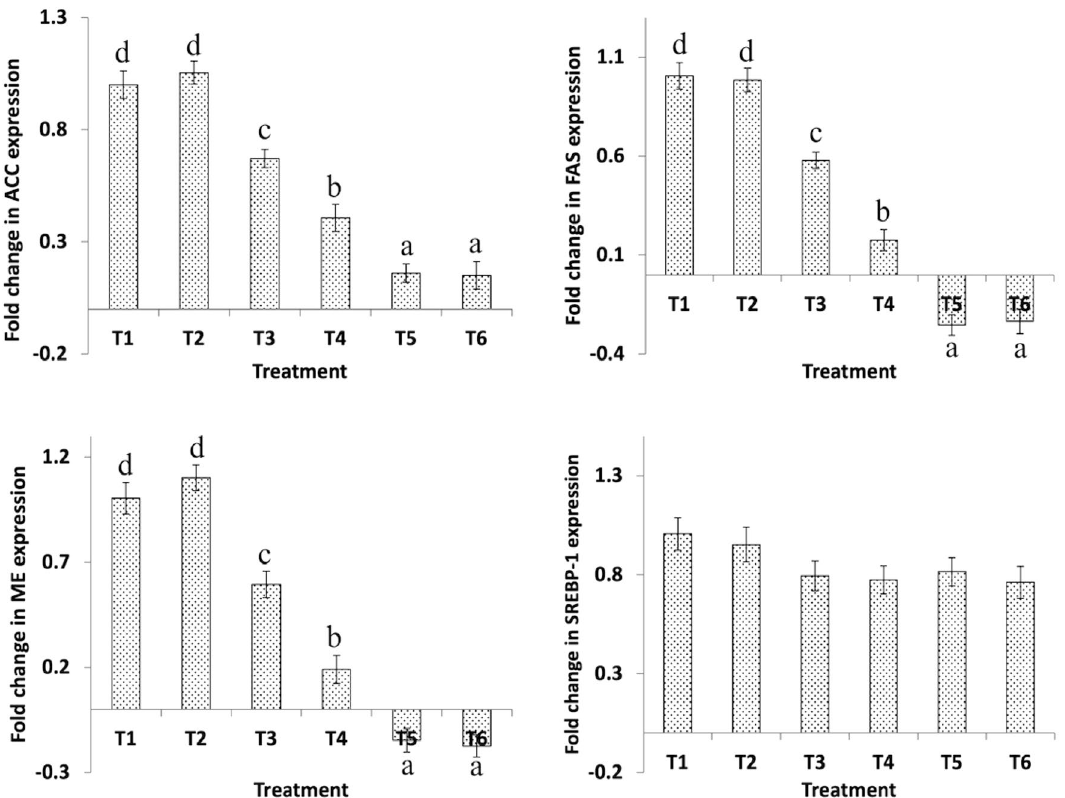
Figure 3. Effect of dietary B. Bifidum (BFD) and mannan-oligosaccharides (MOS) on hepatic ACC, FAS, ME, and SREBP-1 gene expression in 42 days old broiler chicken. T 1 (no BFD/MOS/BMD), T 2 (20 mg BMD/kg diet), T 3 (0.1% MOS + 10 6 cfu BFD/g feed), T 4 (0.1% MOS + 10 7 cfu BFD/g feed), T 5 (0.2% MOS + 10 6 cfu BFD/g feed), T 6 (0.2% MOS + 10 7 cfu BFD/g feed). Results are presented as means ± SEM with six birds per treatment. Means values with different superscripts letters differ significantly (P <